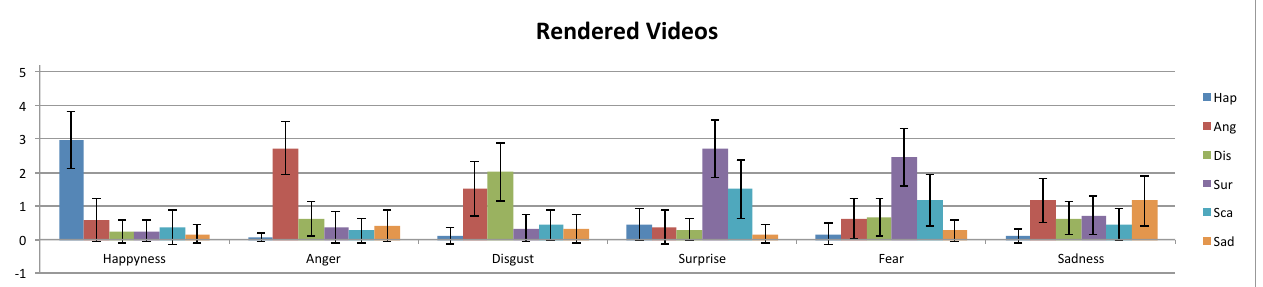
Figure 10. Rating obtained for the rendered videos (avatar) for each expression.